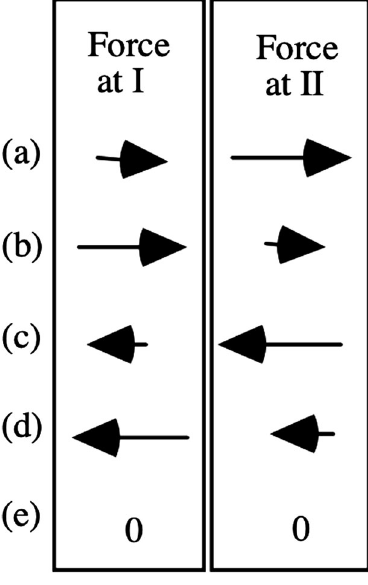
FIG. 4. Answer choices for